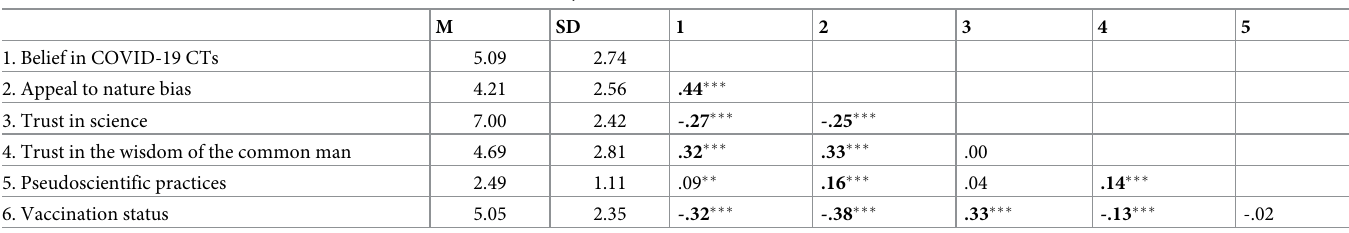
Table 7. Means, standard deviations and Pearson correlations—Study 2.